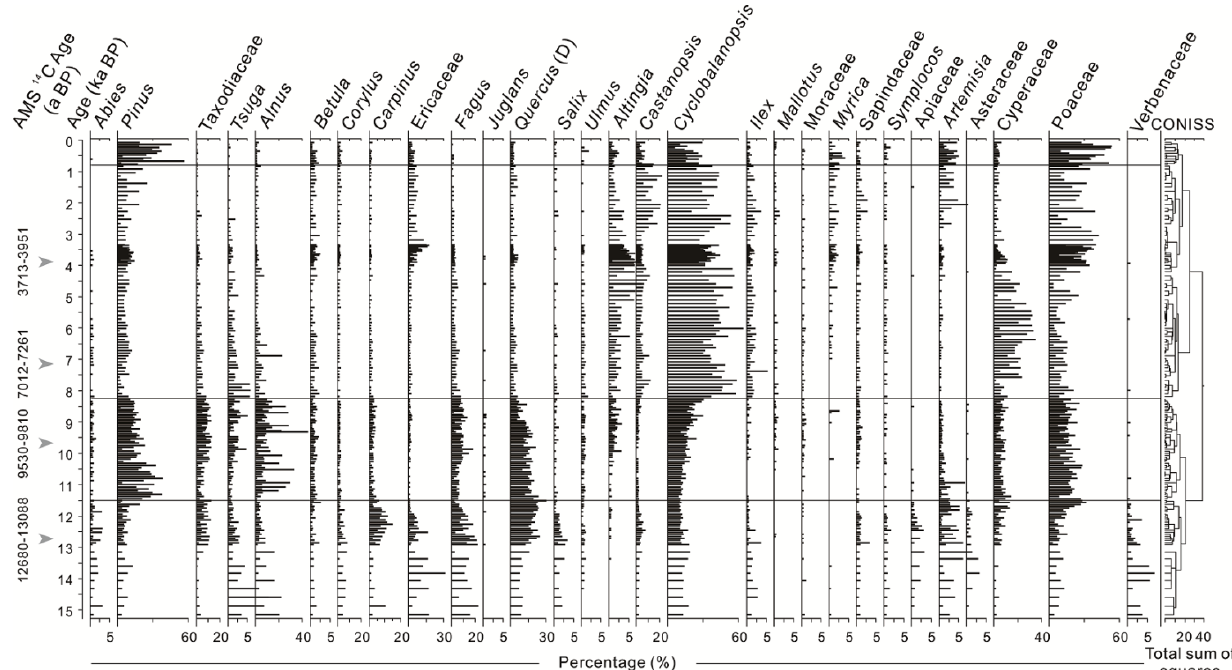
Figure 2. Pollen diagram of selected taxa from the SZY record of the last 15,000 years. All relative abundances were calculated based on total pollen sum.